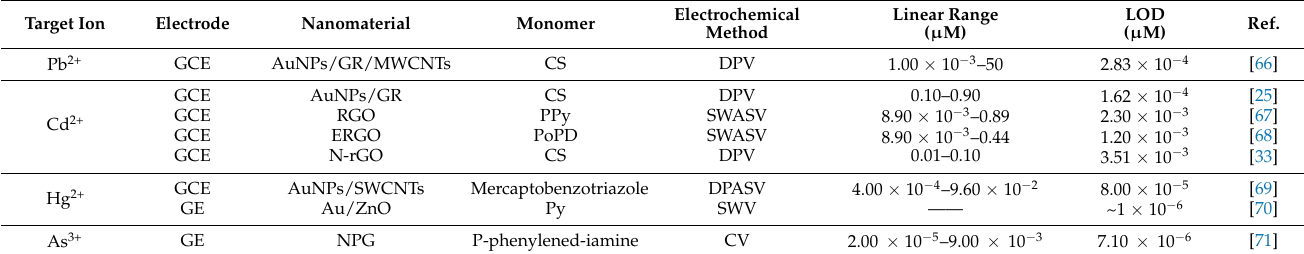
Figure 8. Cyclic voltammograms of GCE, GO@GCE, NIP/GO@GCE, unleached IIP/GO@GCE and leached IIP/GO@GCE in Cd(II) solution buffered with acetate. Reprinted with permission from Ref. [106]. Copyright 2021, the Royal Society of Chemistry.